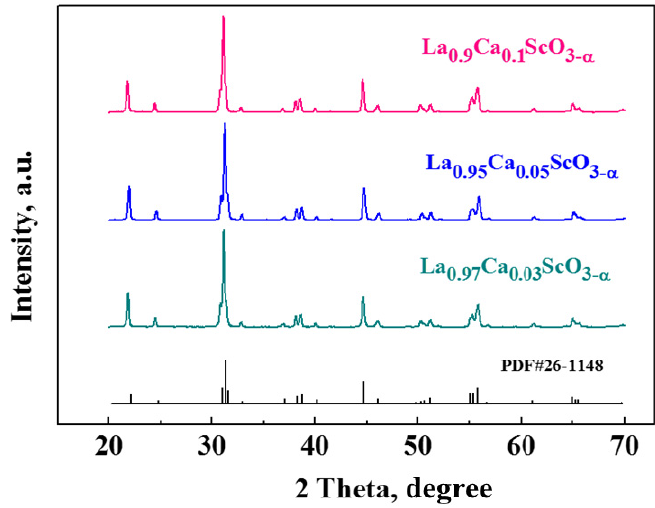
Figure 2. XRD patterns of LCS3, LCS5 and LCS10. Table 1. Unit cell volume and density of ceramic samples.